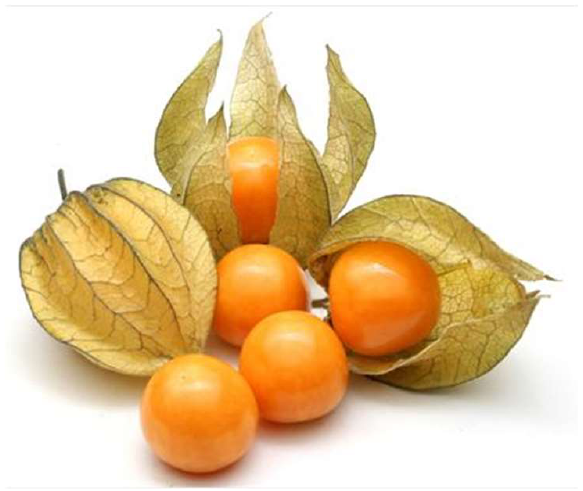
Figure 24. P. peruviana (Cape gooseberry) fruits with husks as commercialized by local producers from the Dota and Paraiso regions in Costa Rica.